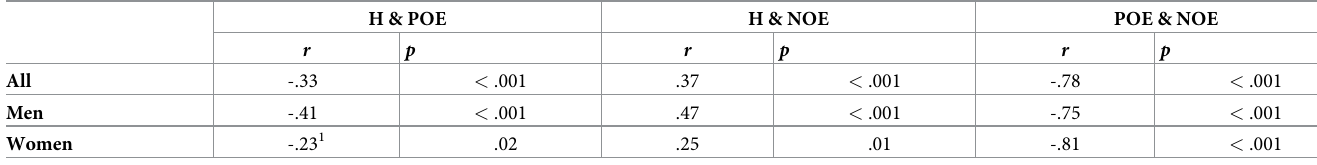
Table 2. Harassment perception and outcome expectancy correlations.